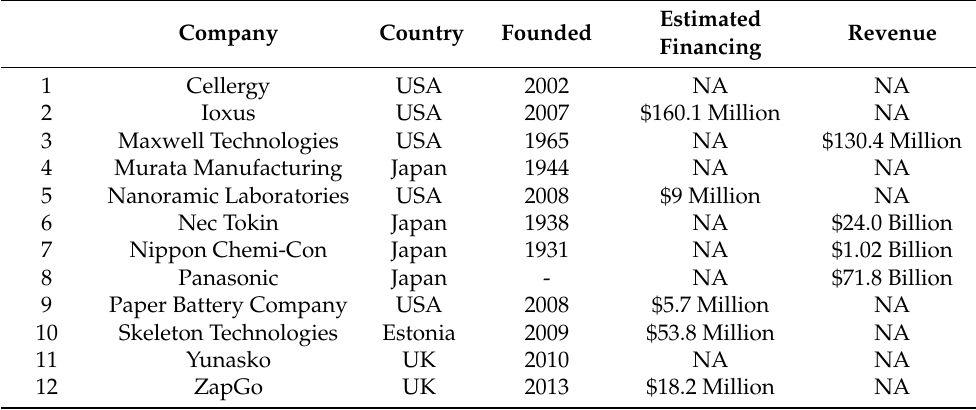
Table 2. Top 12 SC manufacturers in the world and their primary information [133].